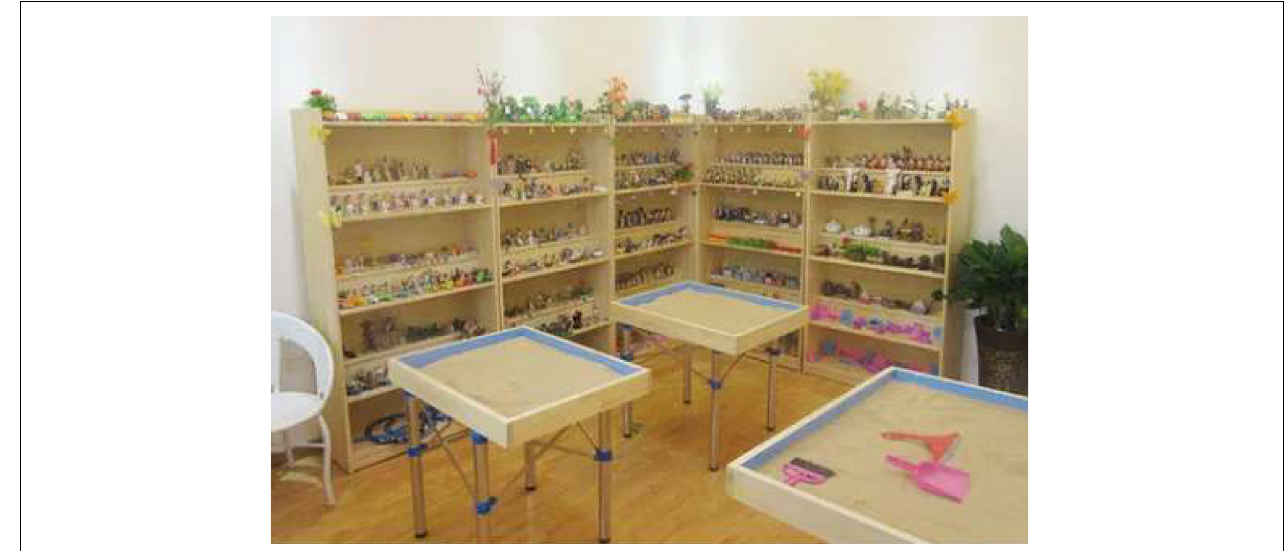
FIGURE 1 | Sand Table game and treatment scene.